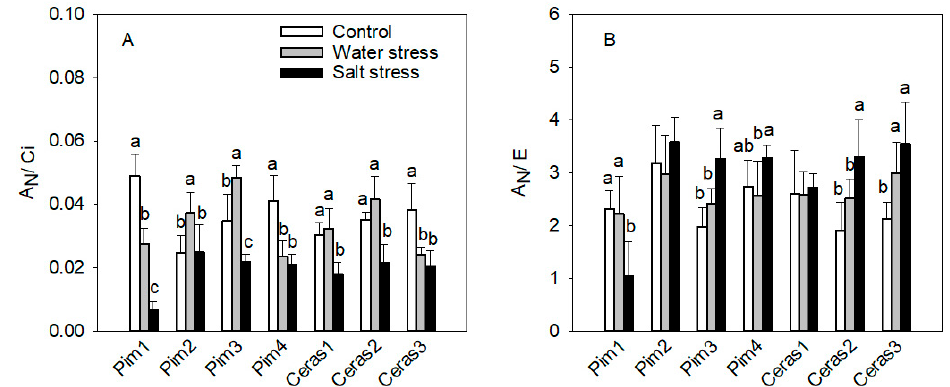
Figure 3. Instantaneous carboxylation e ffi ciency (A N / Ci) ( A ) and instantaneous water use e ffi ciency (A N / E) ( B ) in accessions Pim1, Pim2, Pim3, Pim4, Ceras1, Ceras2 and Ceras3 under control, water stress and salt treatment after 120 days of treatment. Data are mean values ± SE for n = 8 plants. Within